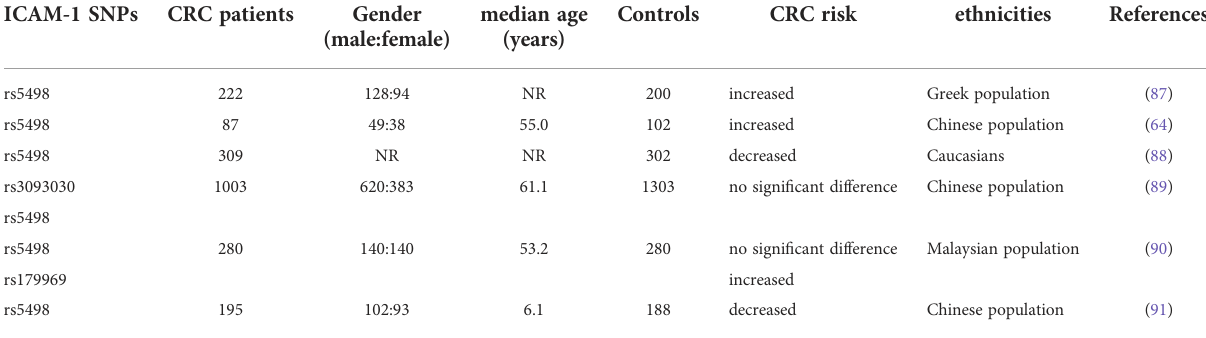
TABLE 2 The relationship between CRC risk and ICAM-1 SNPs. ICAM-1